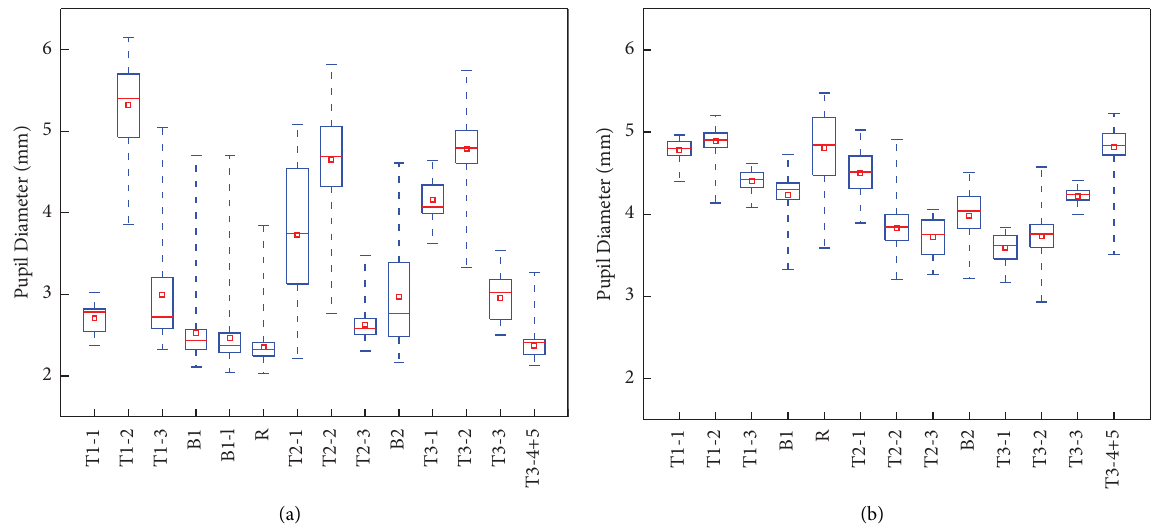
Figure 6: Box diagram of PD. (a) Day. (b) Night.